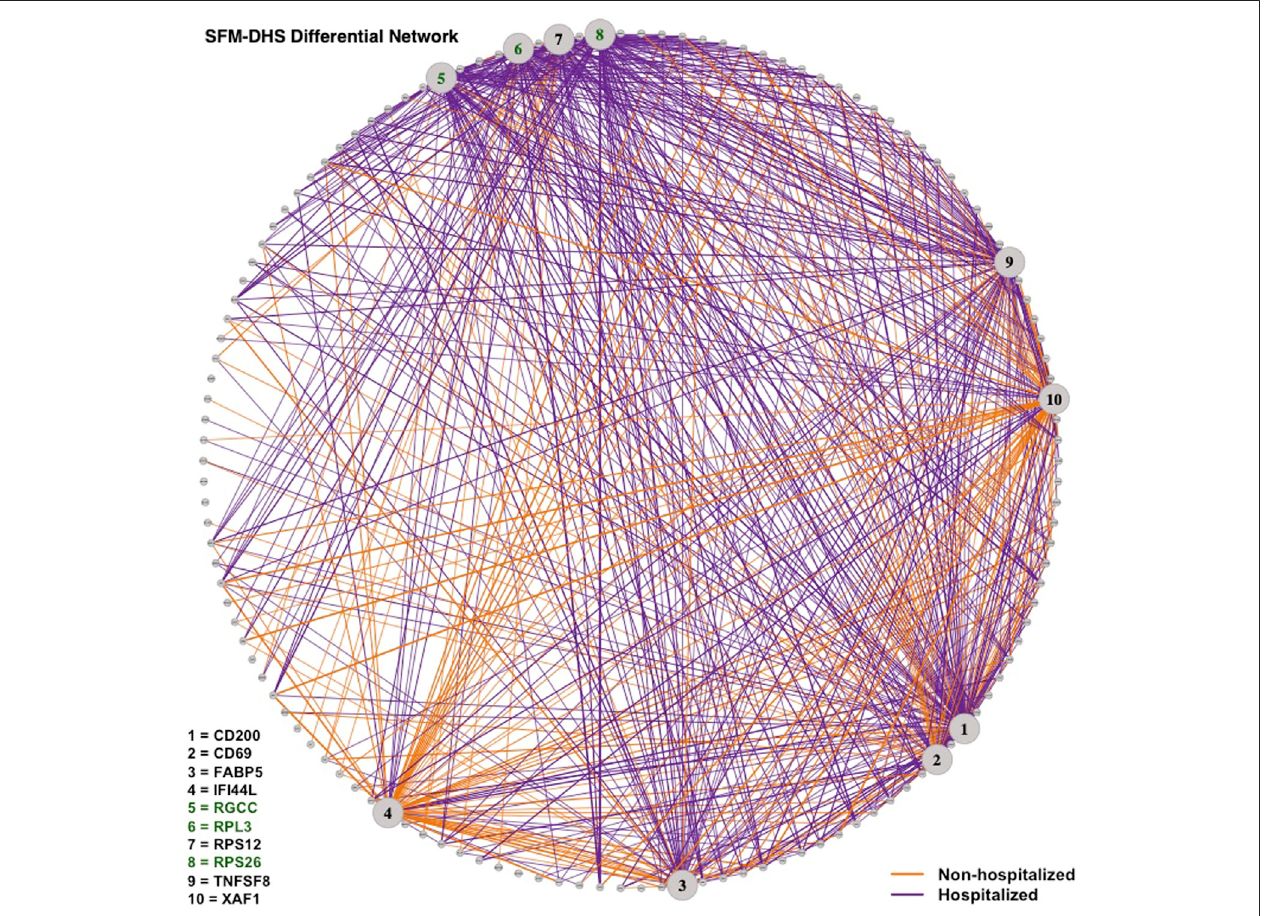
FIGURE7 | Differential network estimated bySFM-DHS with the bootstrap procedure for theSARS-CoV-2case study dataset. Edges displayed arefor 10DCGs. The 7 unique top DCGs identi fi ed by both SFM-SHS and SFM-DHS are listed in black and the 3 top DCGs identi fi ed by all considered methods are listed in green. Each edge color represents the group with the larger correlation